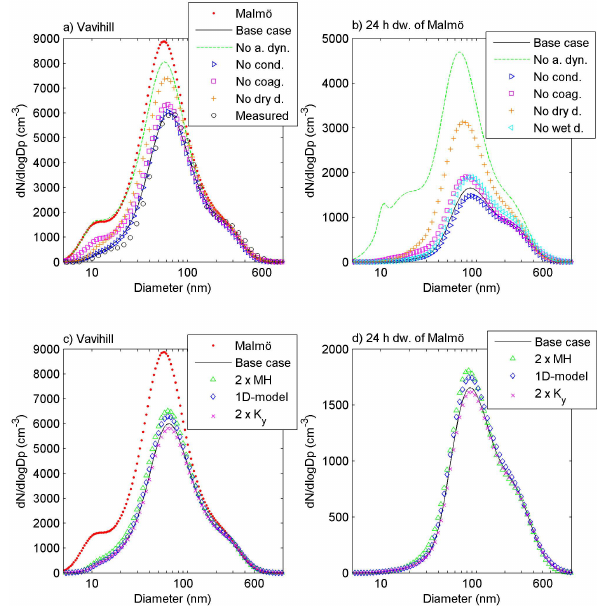
Fig. 5. Modeled particle number size distributions in the center of the urban plume at Vavihill ( a and c ) and 24h downwind of Malm¨o (b and d), without different aerosol dynamic processes ( a and b ) and changed vertical or horizontal mixing ( c and d ). Panels (a) and (b) give the results from the simulations with all aerosol dynamic processes included (base case), no aerosol dynamic processes, no condensation, no coagulation, no dry deposition and no wet depo- sition (only in b )). Panels (c) and (d) display the results from the base case simulation, doubled mixing height (MH), no horizontal mixing (1D-model) and doubled horizontal mixing (2 × K y ) . In (a) the modeled (fitted) particle number size distribution at the mea- surement station in Malm¨o and the measured particle number size distribution at Vavihill is also